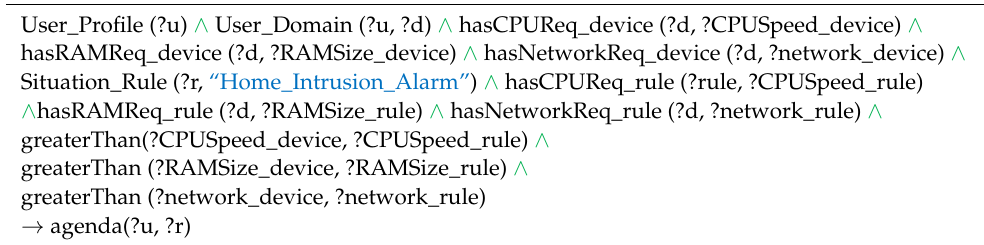
Algorithm 4: Check Device’s Requirements with Situation